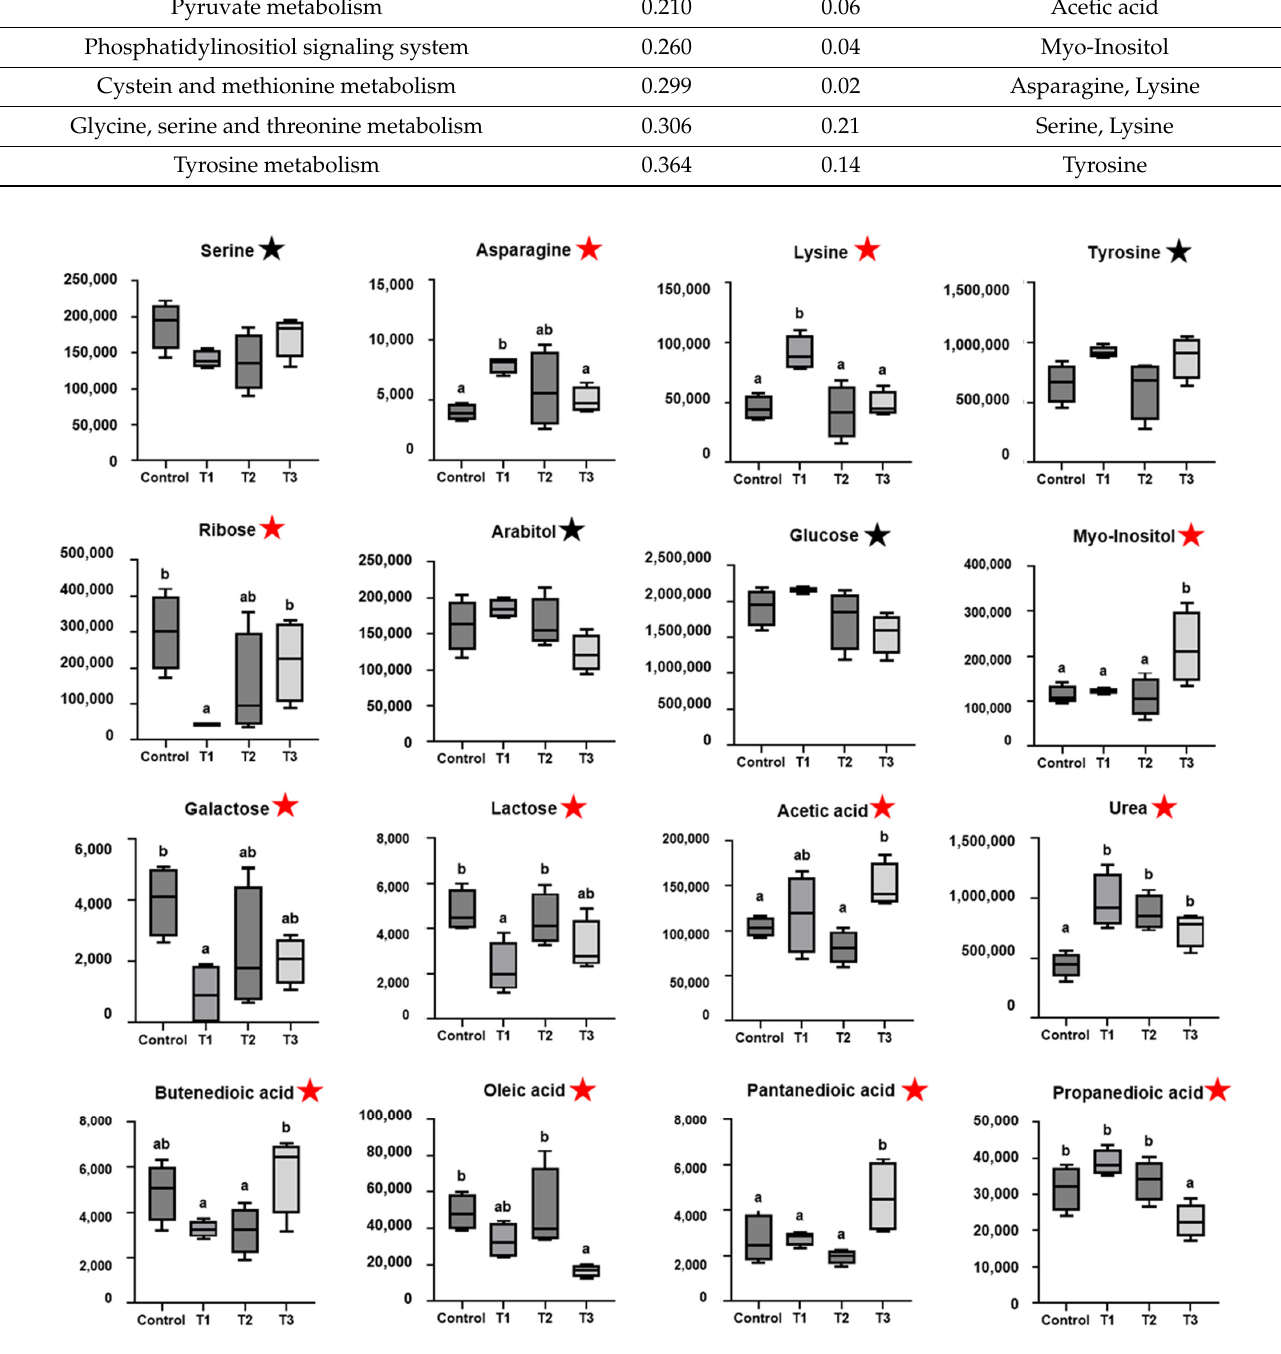
Figure 2. Metabolomics parameters ( n = 4) in serum (Control, T1, T2, T3; VIP > 0.7, p < 0.05 ( ★ ), p